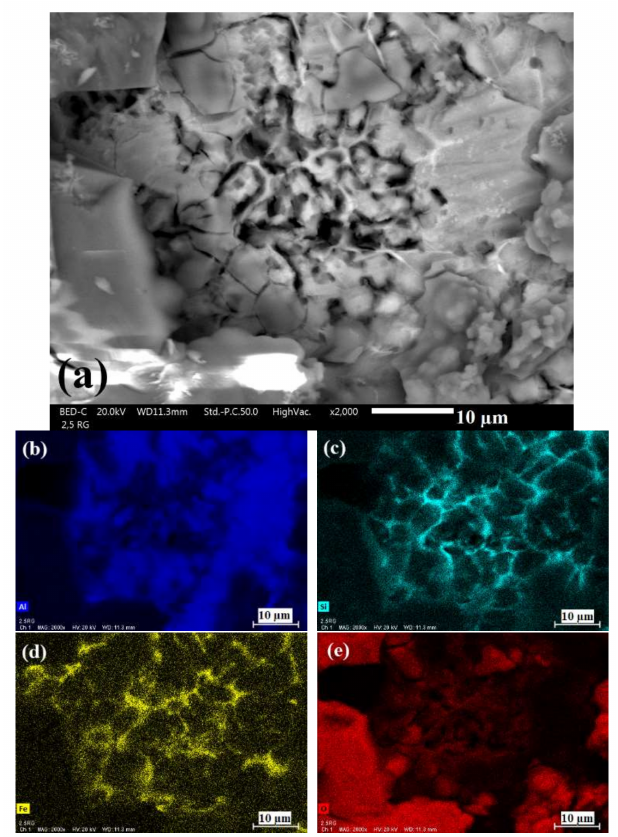
Figure 19. ( a ) SEM micrograph and elemental map analysis of corroded surface of sample 2.5 RG; ( b ) Al; ( c ) Si; ( d ) Fe; and ( e )